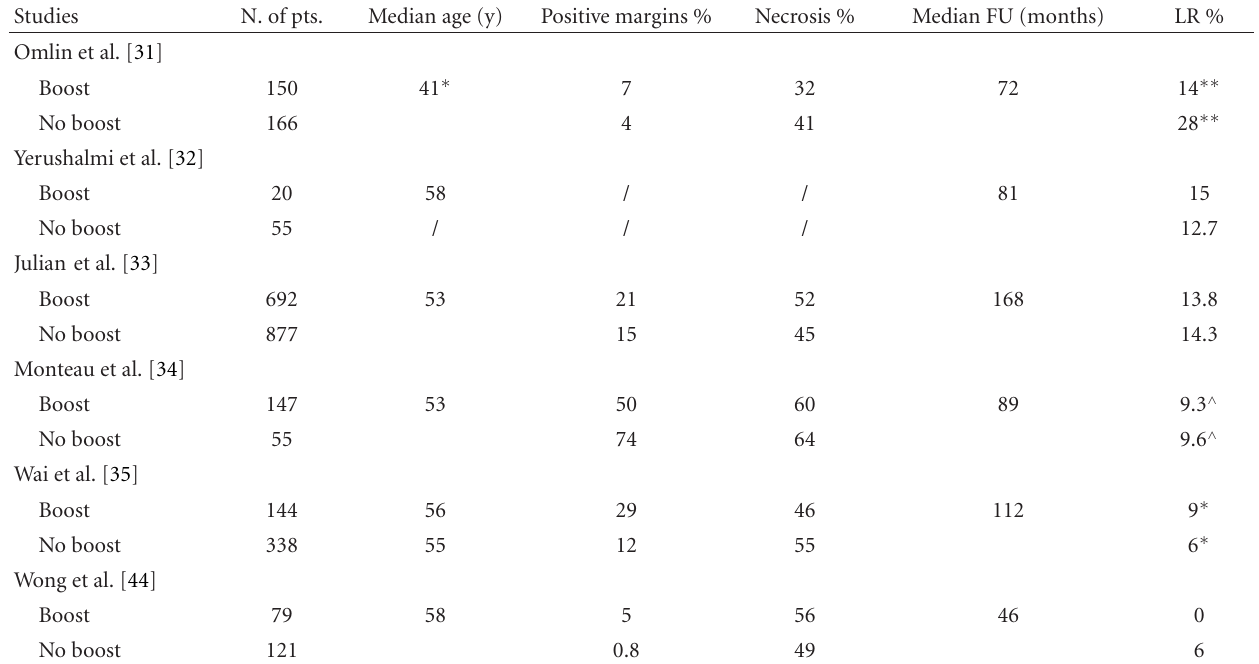
Table 3: The influence of the boost on local